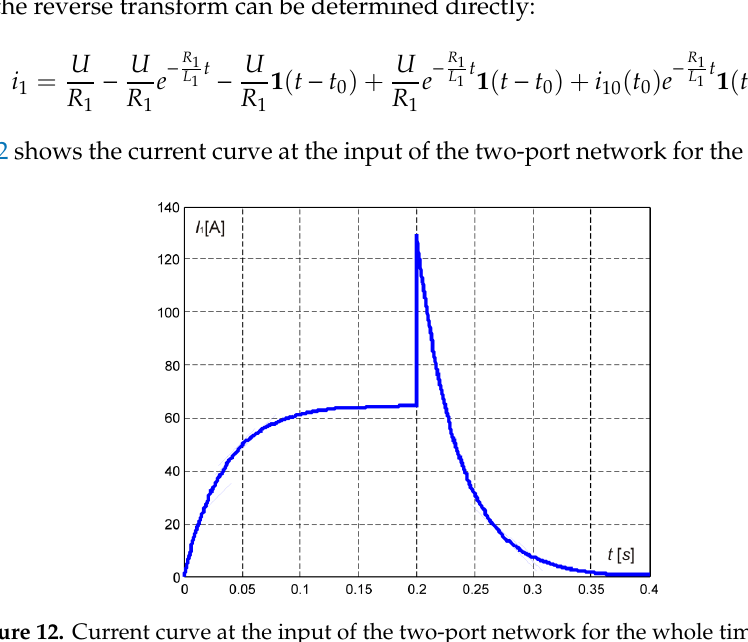
Figure 12. Current curve at the input of the two ‐ port network for the whole time interval.